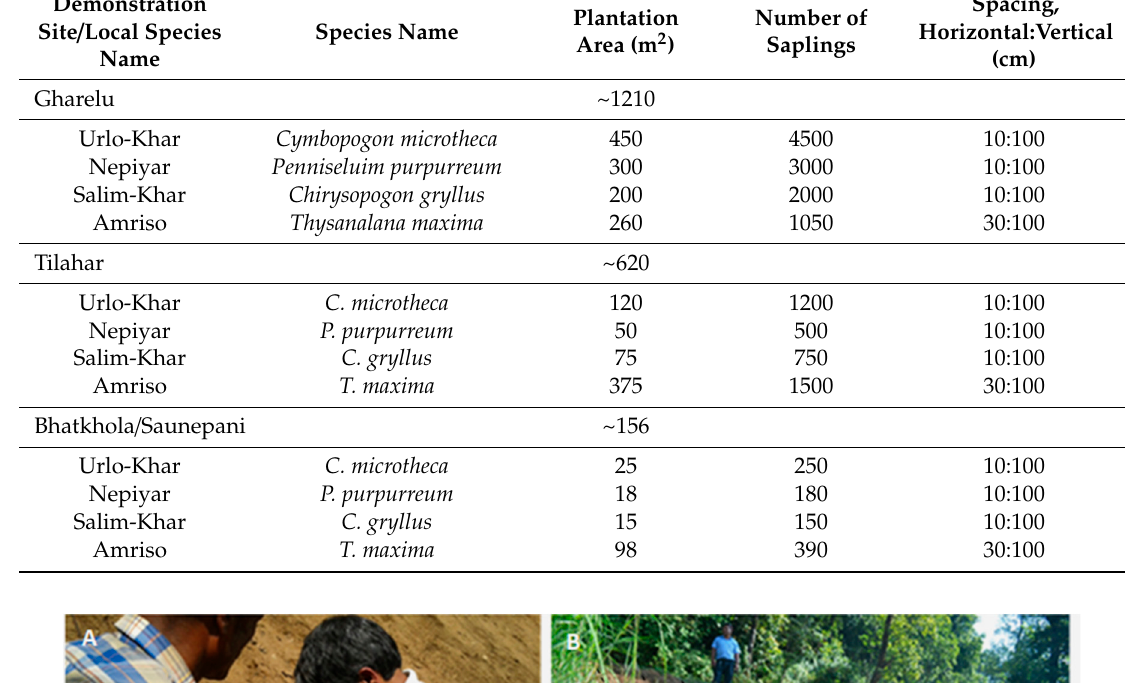
Table 2. Number of seedlings planted in each demonstration site monitored by the community members. Demonstration